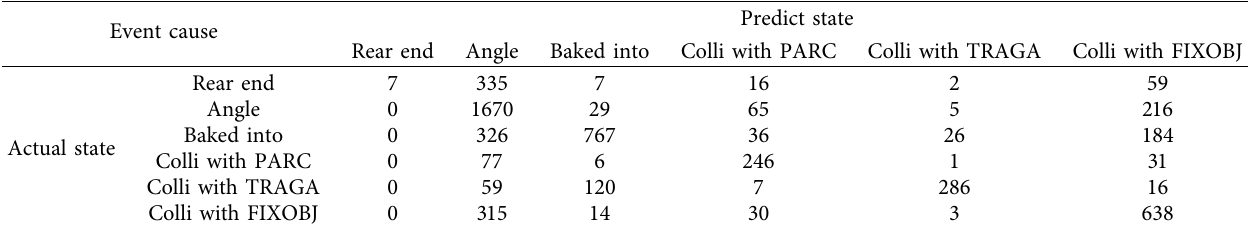
Table 7: Te confusion matrix for event